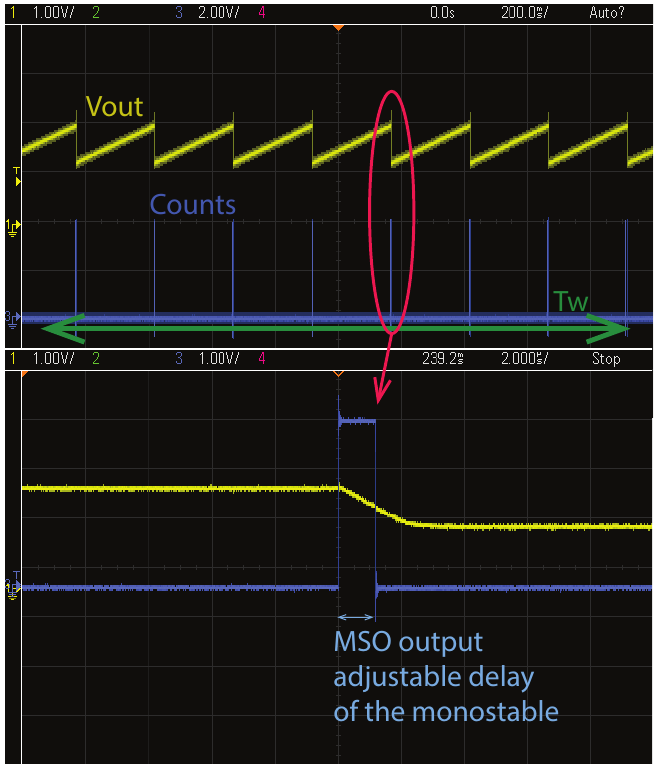
Figure 10. Analog output of the integrator V out and number of counts (MSO signal) shown in the oscilloscope. The CFC operating principle is shown.